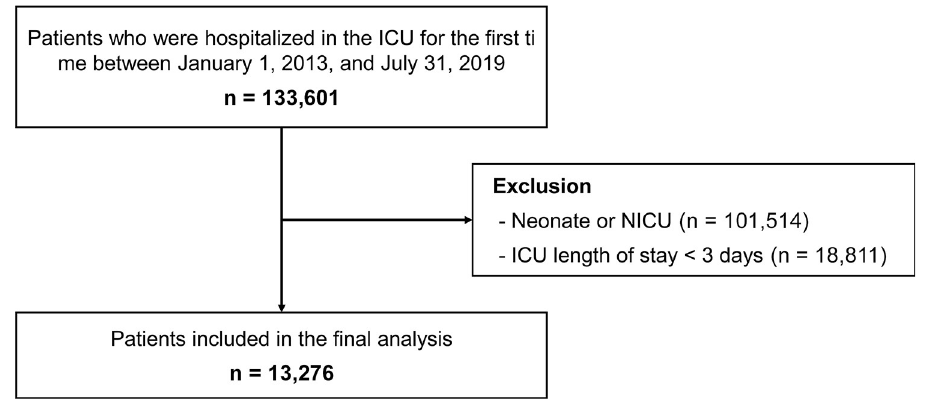
Fig 1. Study flow chart of patient inclusions and exclusions. ICU, intensive care unit; NICU, neonatal intensive care unit.